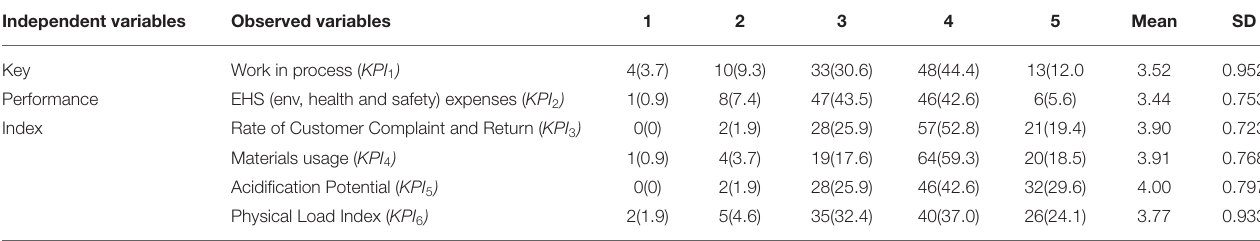
TABLE 10 | Key Performance Indicators (KPI) of palm oil mill’s SSCM. Independent